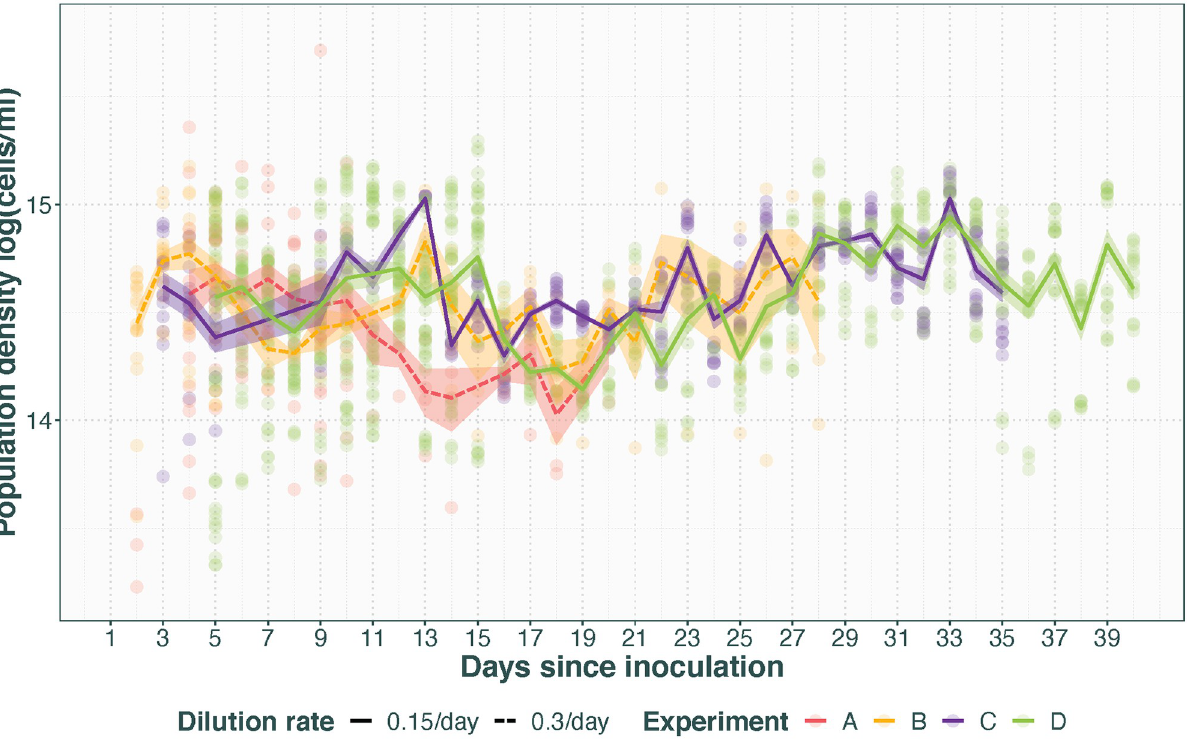
Fig 1. Population density with time in four separate runs of the mesostat system. Transparent points represent technical replicates and opaque lines with standard error represent average across populations for experiment. Experiments A and B had a dilution rate of 0.3/day (dashed line), whereas experiments C and D had a dilution rate of 0.15/day (solid line). Note that all have runs have a brief and rapid decline in population density between day 11 and 16. This corresponds to an injection of additional medium as part of the experiment the data is from.